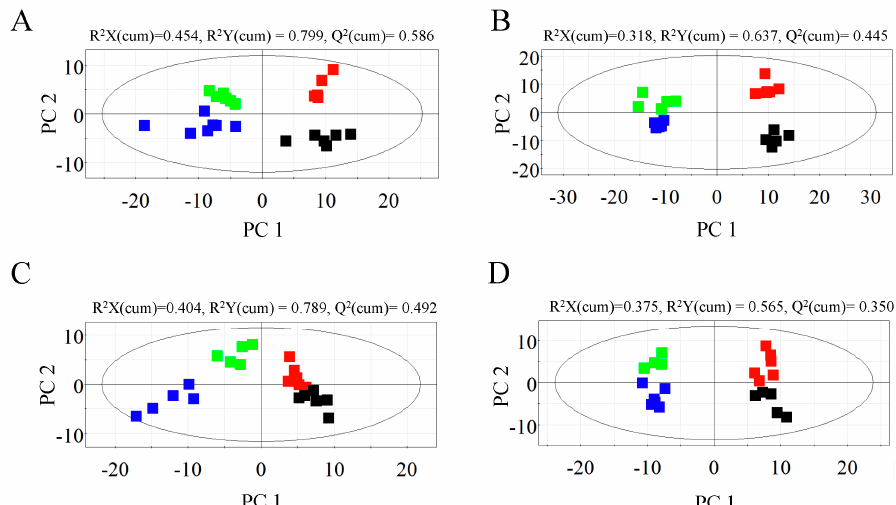
Figure 1. PLS-DA score plots derived from spectra of mock- and A. germari -infected samples. ( A , B ) Score plots for the polar ( A ) and lipophilic profiles ( B ) for bark samples; ( C , D ) Score plots for the polar ( C ) and lipophilic profiles ( D ) for xylem samples. R 2 X (cumulative) and R 2 Y (cumulative) represented the cumulative fraction of the x and y variance in the model, respectively. Q 2 (cumulative) reflects the predictive capacity of the model. Black and red dots represented mock- and A. germari -infected samples, respectively, at stage I. The green and blue squares represented mock- and A. germari -infected samples, respectively, at stage